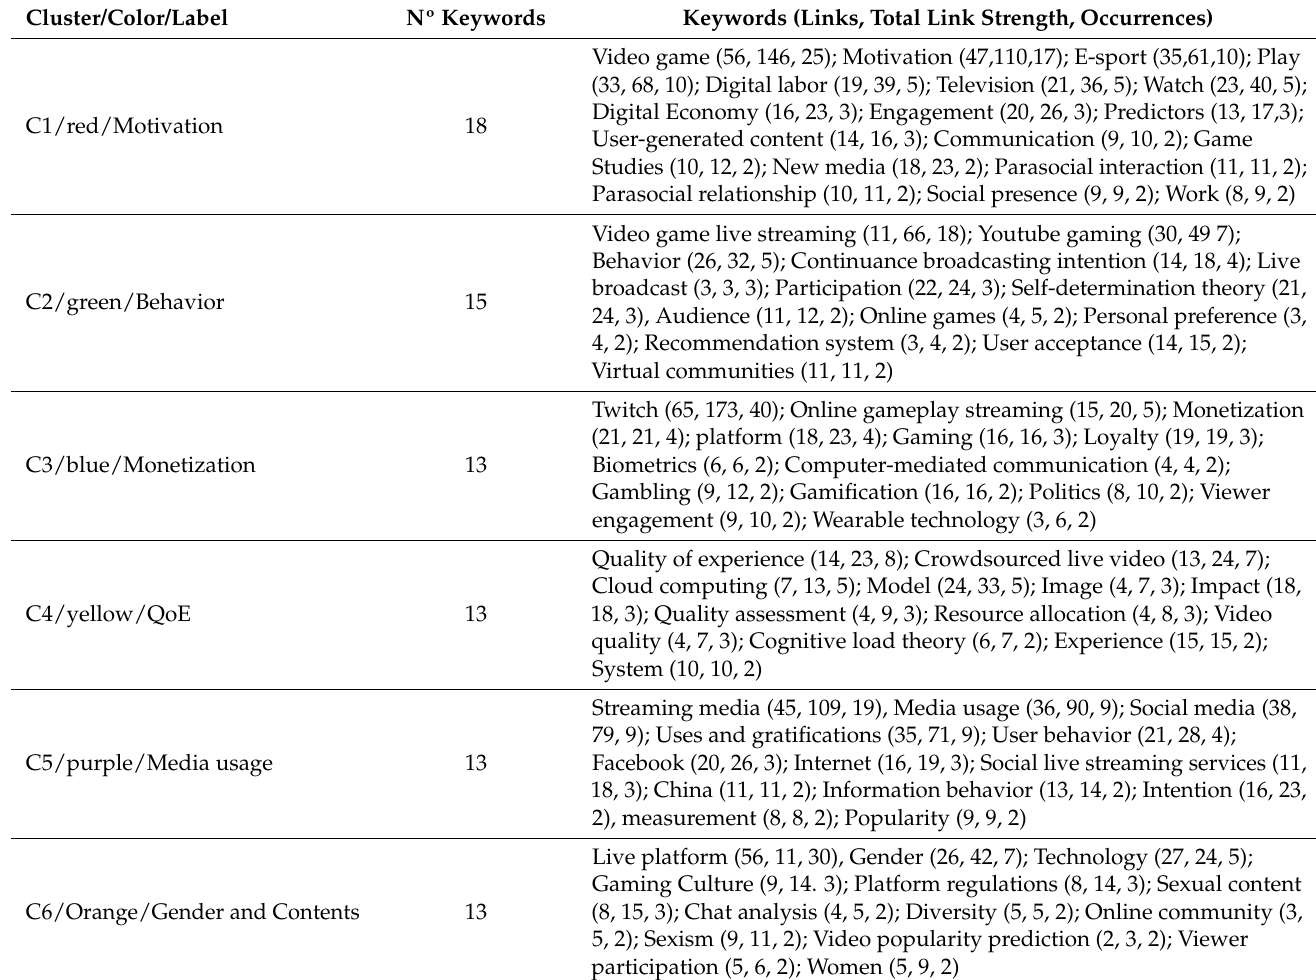
Table 5. Thematic clusters identified in the research domain on video game live streaming. Keywords (Links, Total Link Strength,